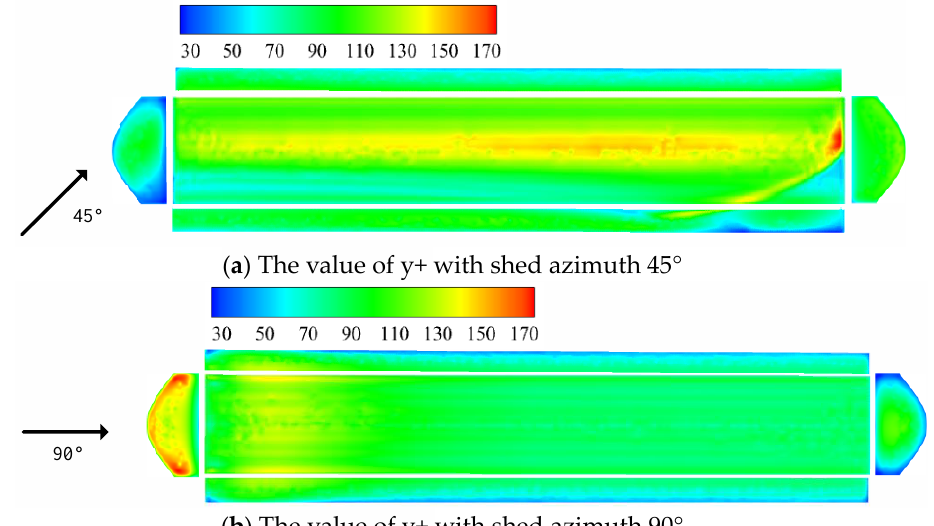
Figure 7. The value of y+ on the surface of the greenhouse.